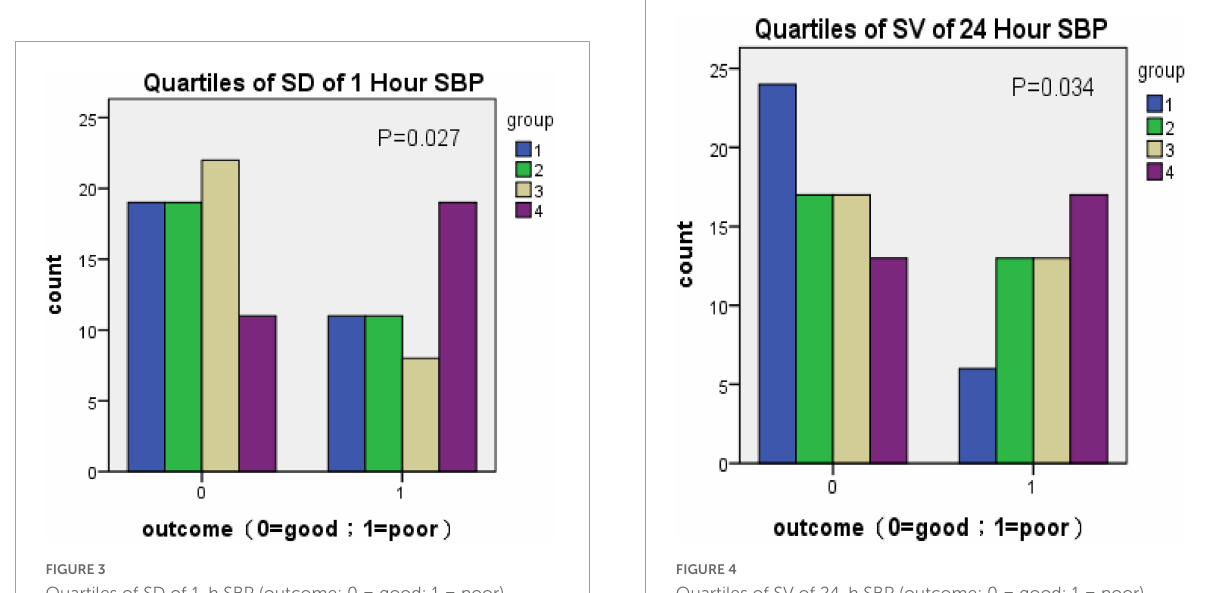
FIGURE2 Quartiles of Max-Min of 24-h SBP (outcome: 0 = good; 1 = poor).